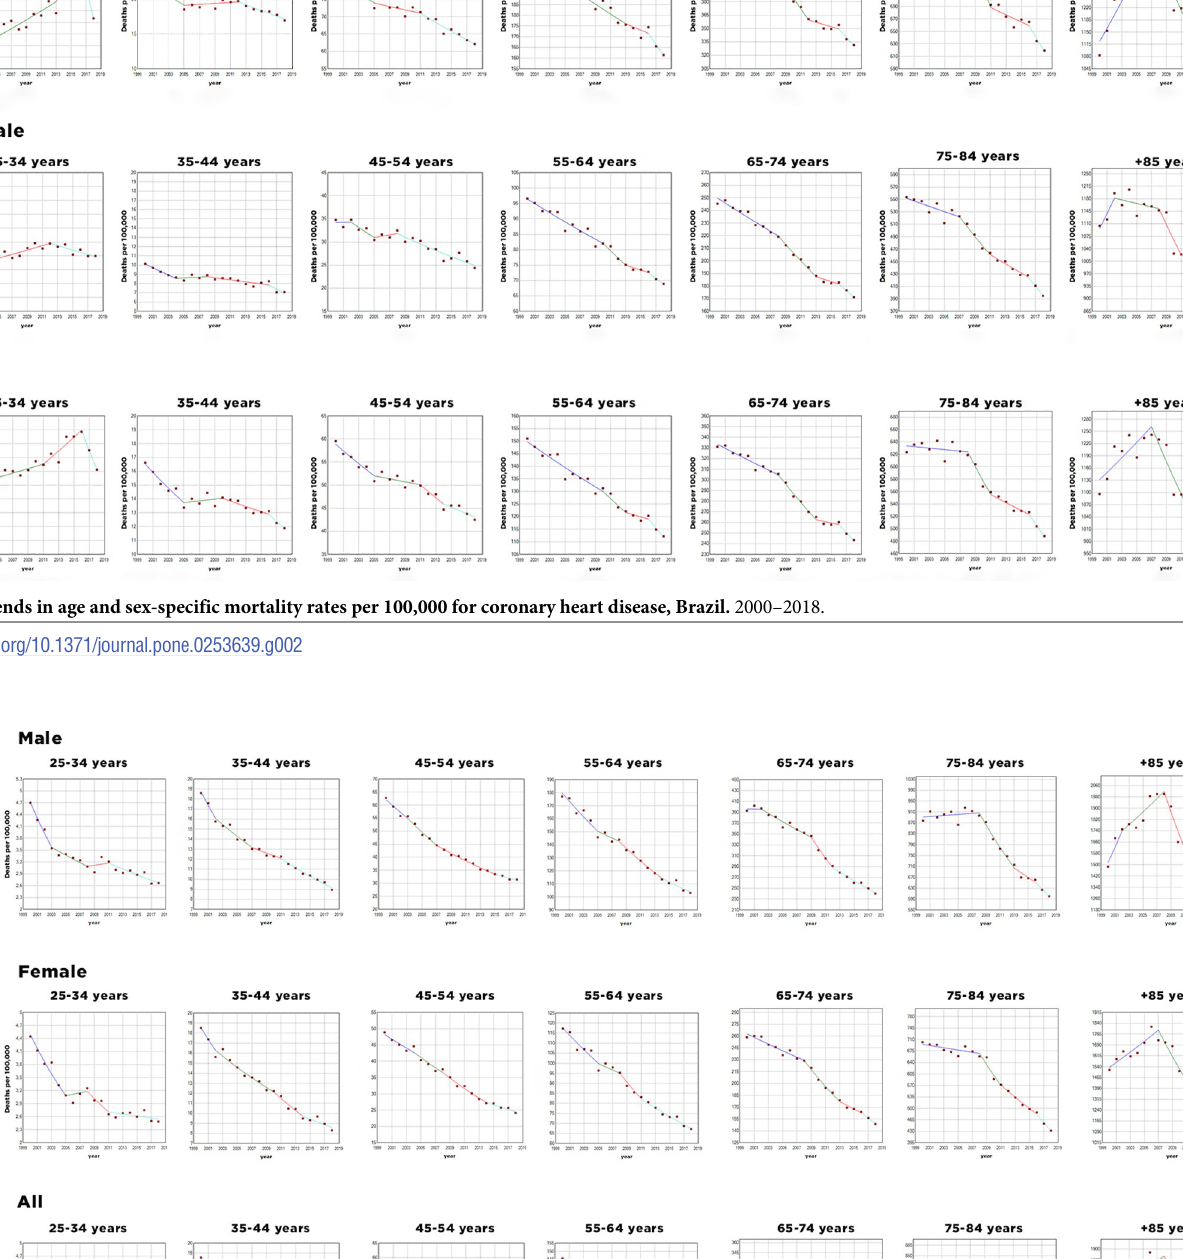
PLOS ONE | https://doi.org/10.1371/journal.pone.0253639 September 2, 2021 4 /